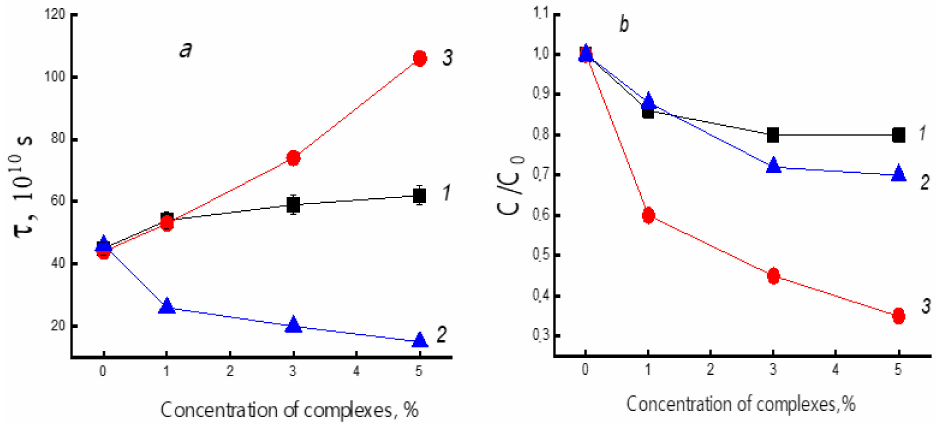
Figure 6. Dependences of probe correlation time τ ( a ) and relative probe concentration C/C 0 ( b ) on dopant content: TPP (1), SnCl 2 -TPP (2), and FeCl-TPP